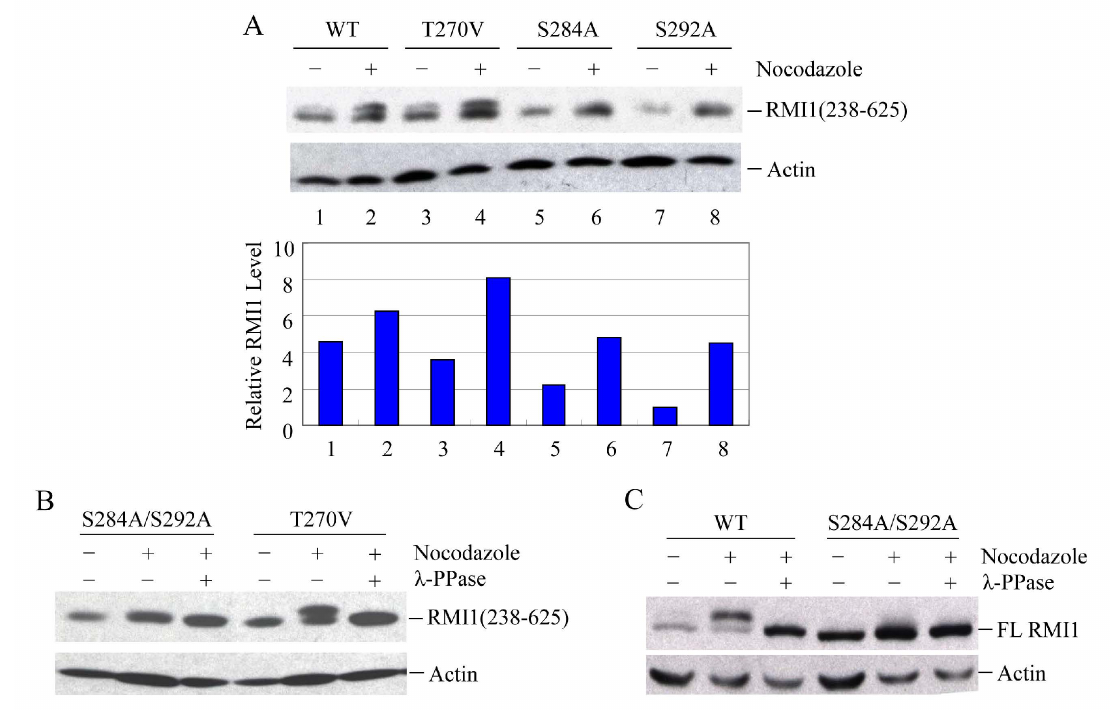
Figure 4. Ser284 and Ser292 are RMI1 mitotic phosphorylation sites. The indicated RMI1 mutants were transiently transfected into 293T cells followed by nocodazole treatment or not for 16 h. Ectopic expression of wild type (WT), T270V, S284A or S292A ( A ); or S284A/S292A, T270V mutation of RMI1 (238–625) fragment ( B ); ( C ) Ectopic expression of full-length wild-type RMI1 or S284A/S292A mutant. Nocodazole treatment and phosphatase treatment were applied as indicated. Quantified relative RMI1 protein levels are shown under the corresponding